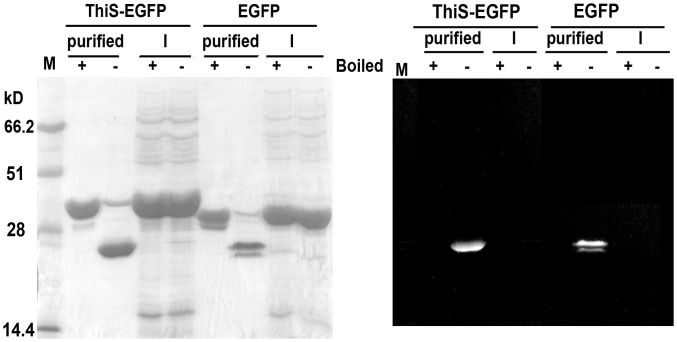
Folded EGFP proteins with or without ThiS fusion retained their native states during SDS-PAGE.Purified EGFP and ThiS-EGFP from supernatants (expressed at room temperature), as well as the proteins solubilized from inclusion bodies (I), were resolved on 12% SDS-PAGE, with (+) or without (−) boiling the samples. The gel was photographed under UV illumination (right panel), then stained by Coomassie blue (left panel). Purified native proteins migrated at faster rate and retained fluorescence after SDS-PAGE, if not heat denatured.